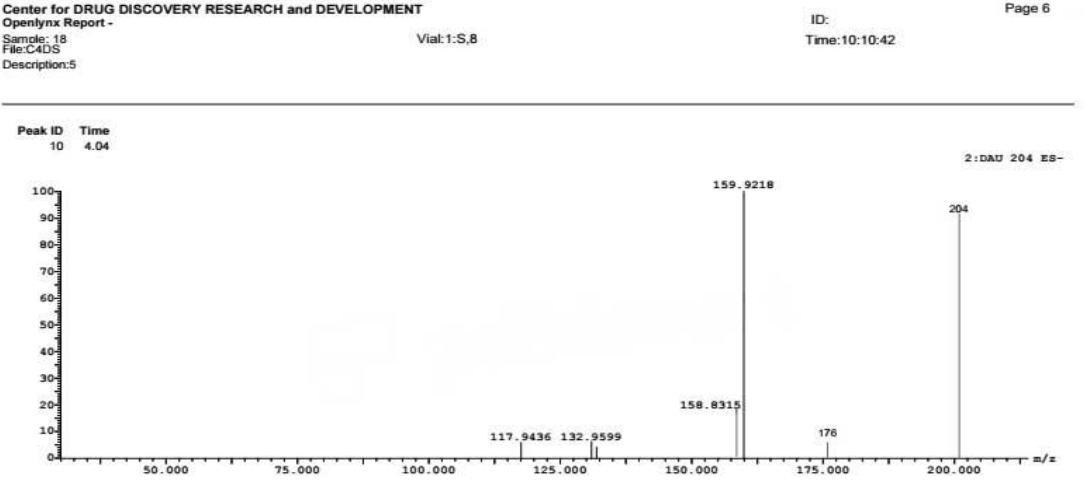
Figure 17. Mass fragmentation for isolated AS1 compound. Table 6. UPLC ESI MS/MS for isolated AS1 compound peak no.